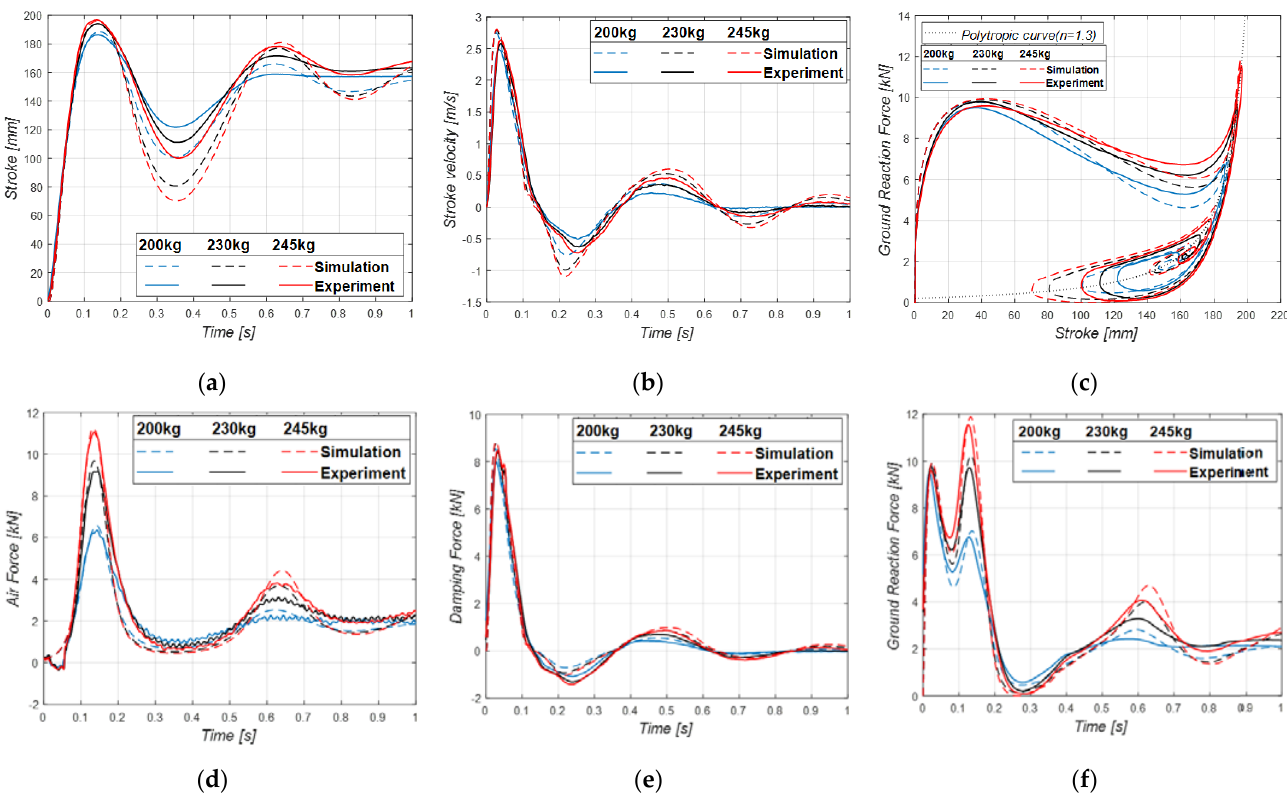
Figure 9. Drop test results for various sprung masses (200 kg, 230 kg, 245 kg), with a sink speed of 3.1 m/s; ( a ) Stroke; ( b ) Stroke velocity; ( c ) Ground reaction force for stroke diagram; ( d ) Air force; ( e ) Hydraulic force; ( f ) Ground reaction force.